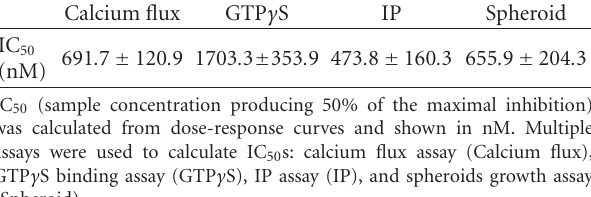
Table 2: Antagonistic activity of MU-6840 for hMRGPRD. Calcium flux GTP γ S IP